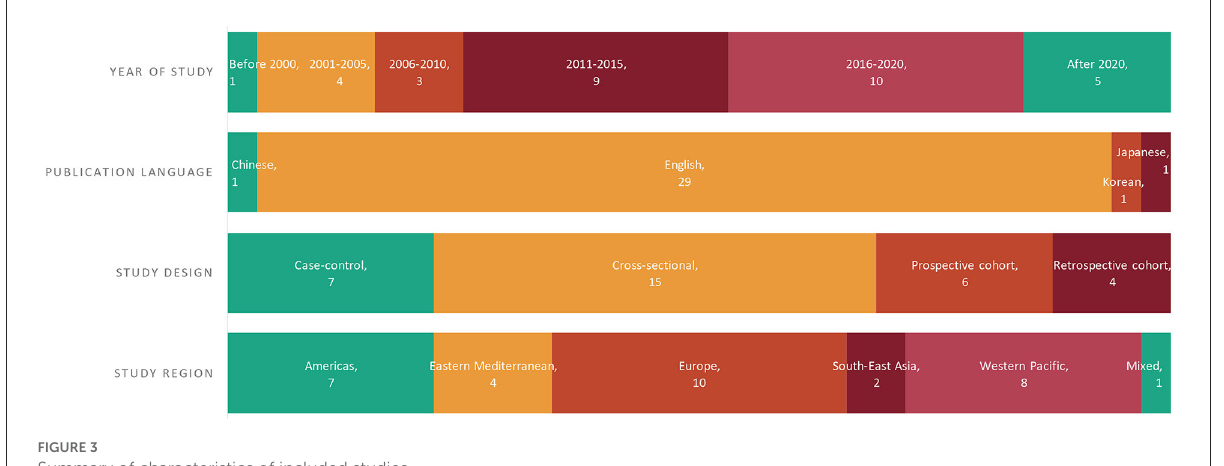
FIGURE3 Summary of characteristics of included